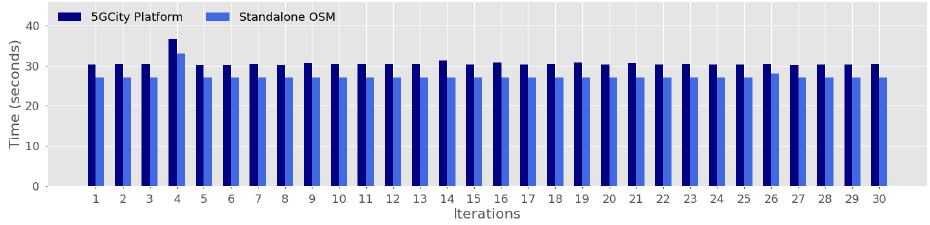
Figure 6. Time overhead against standalone OSM for Service Instantiation Time.